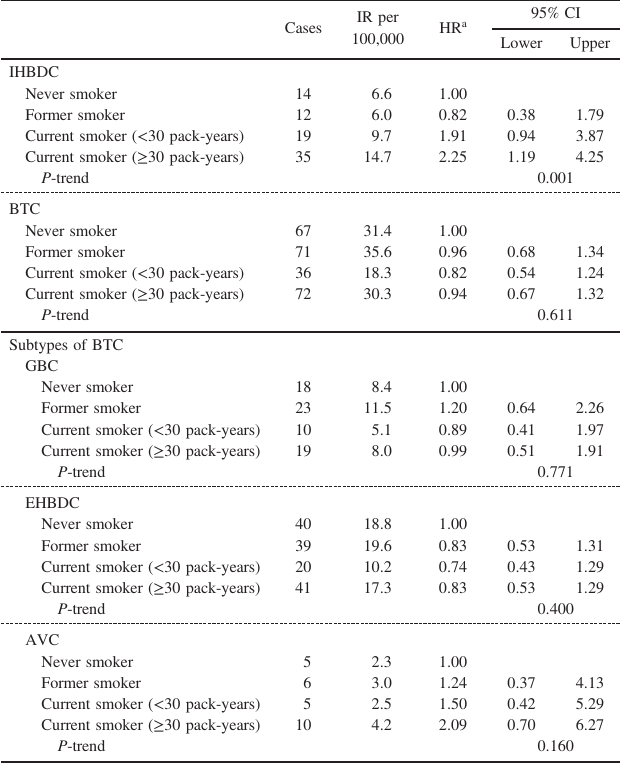
Table 3. HRs and 95% CIs of the incidence of BTC and IHBDC according to alcohol consumption in men